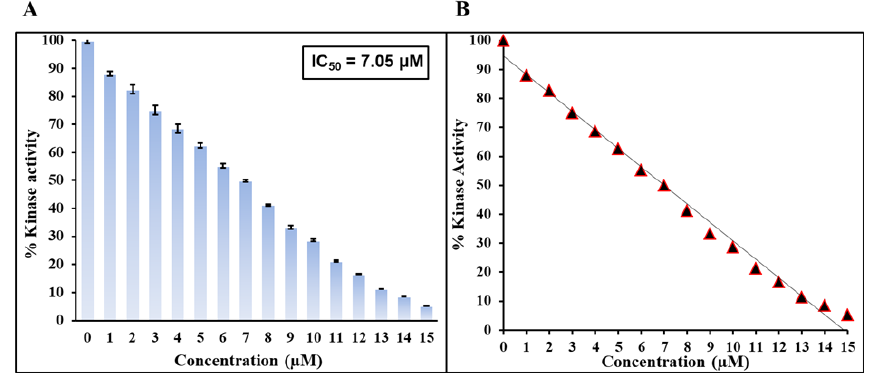
Figure 8. ( A ) ATPase assay of MARK4 with Mtf. The concentration of MARK4 was fixed while Mtf was titrated from 0 – 15 µM. ( B ) Determination of IC 50 value of Mtf.